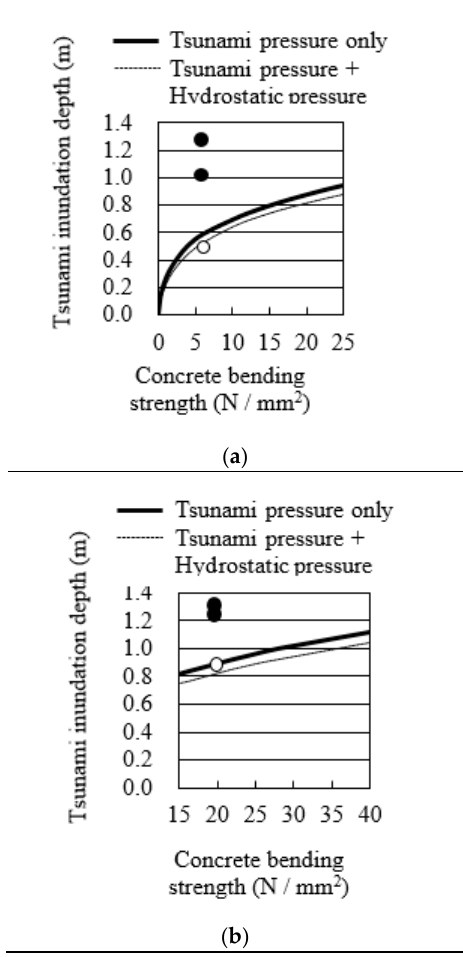
Figure 31. ( a ) Tsunami inundation depth of the limit that does not break (in the case without steel rods). ( b ) Tsunami inundation depth of the limit that does not break (in the case with steel rods).